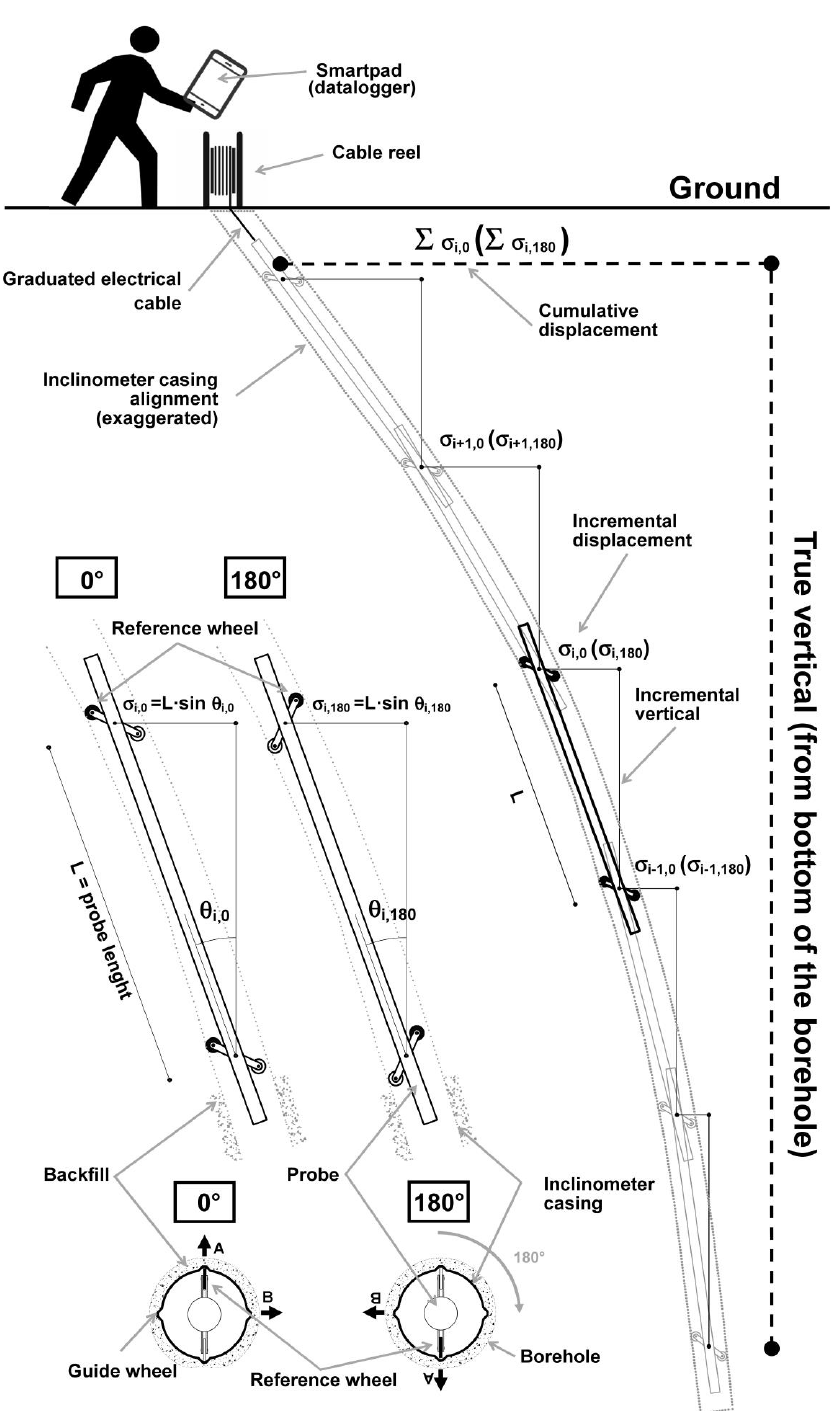
Figure 1. Measurement of horizontal deep-seated ground deformation using inclinometer